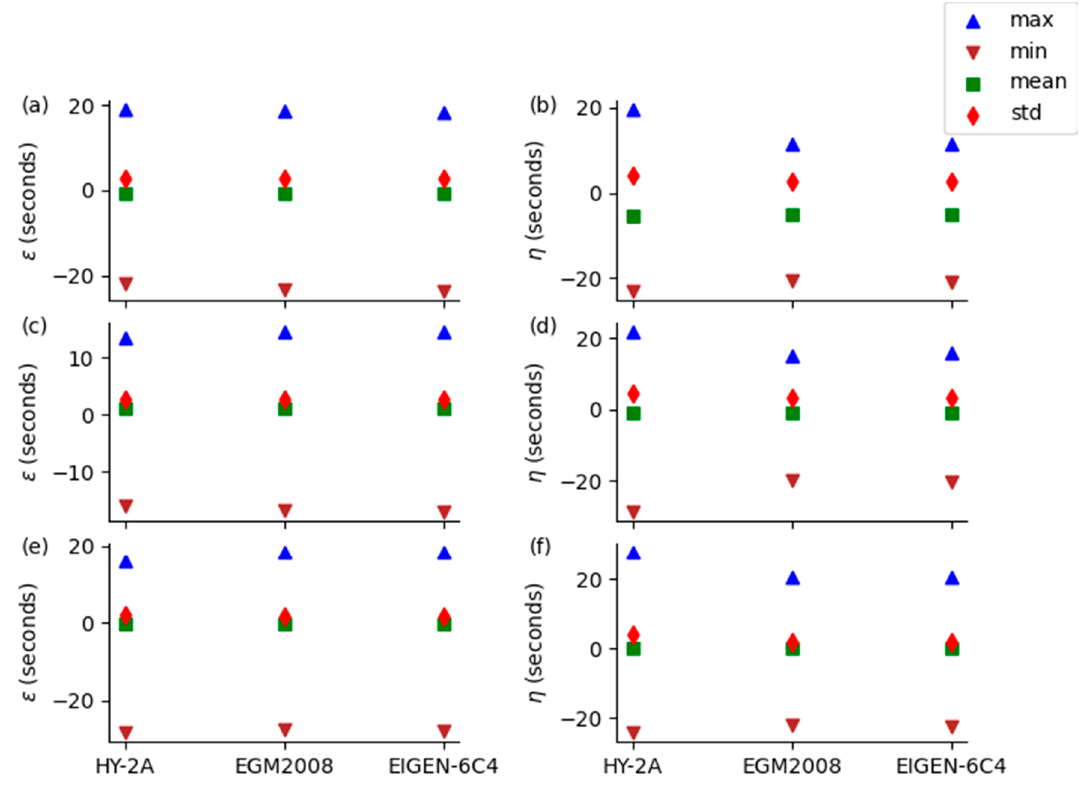
Figure 4. Summary statistics of vertical deflections observed from HY-2A, EGM2008, and EIGEN-6C4 in the three selected oceanic regions: ( a ) North components in Atlantic Ocean; ( b ) East components in Atlantic Ocean; ( c ) North components in Indian Ocean; ( d ) East components in Indian Ocean; ( e ) North components in Pacific Ocean; and ( f ) East components in Pacific Ocean.